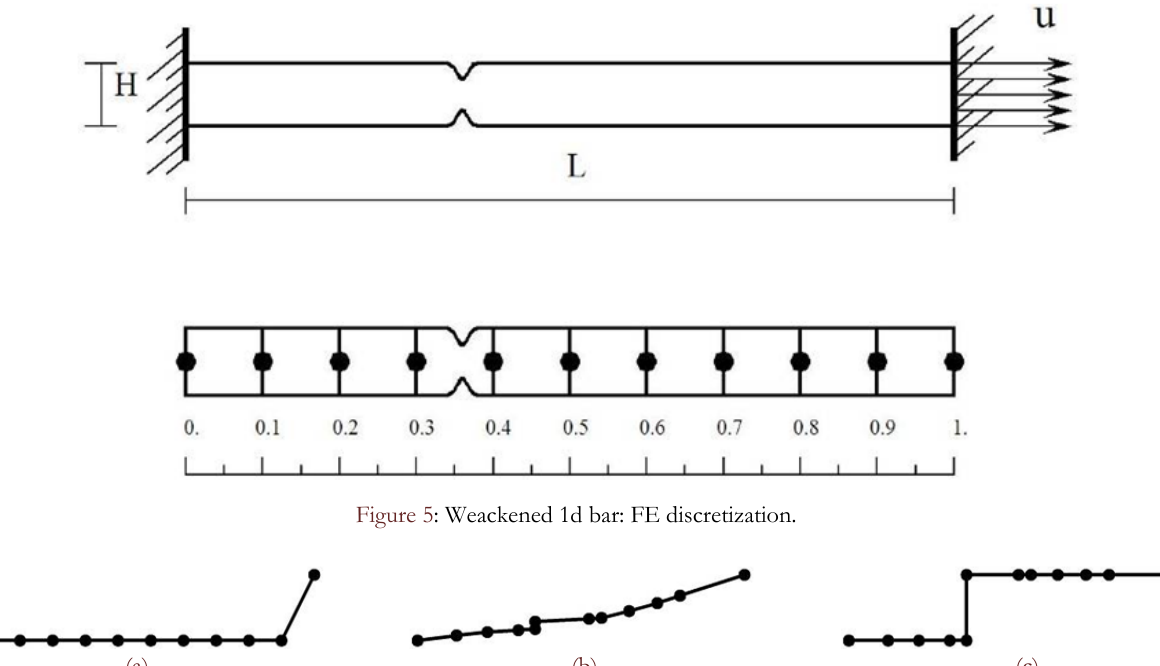
Figure 6: Three snapshots of the evolution of the displacement u and of the node positions a(i), from starting point to convergence (diplacement is represented along the vertical